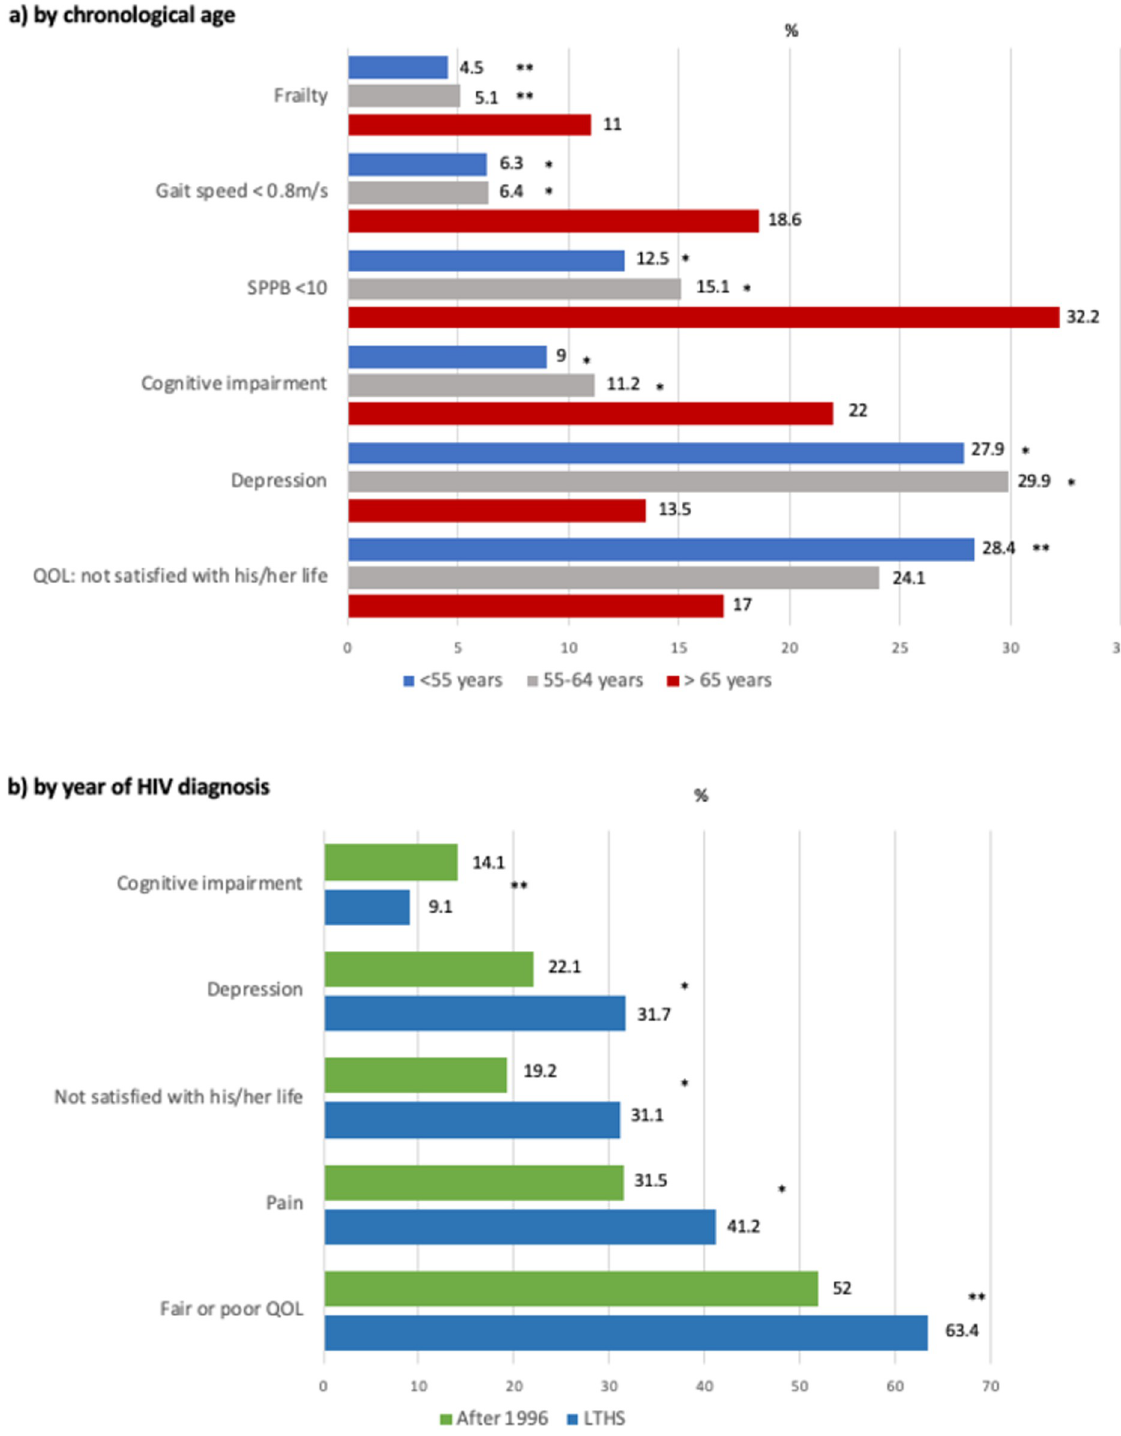
Fig 2. Frailty, physical function, other geriatric syndromes, and quality of life stratified both by chronological age and year of HIV diagnosis. Gait speed < 0.8m/s indicates poor health and functional status and suggests worse than average life expectancy. SPPB: Short Physical Performance Battery. SPPB < 10 indicates functional impairment. QOL: quality of life. � Significant difference with respect to 65 or over group (p < 0.005) �� Significant difference with respect to 65 or over group (p < 0.01).